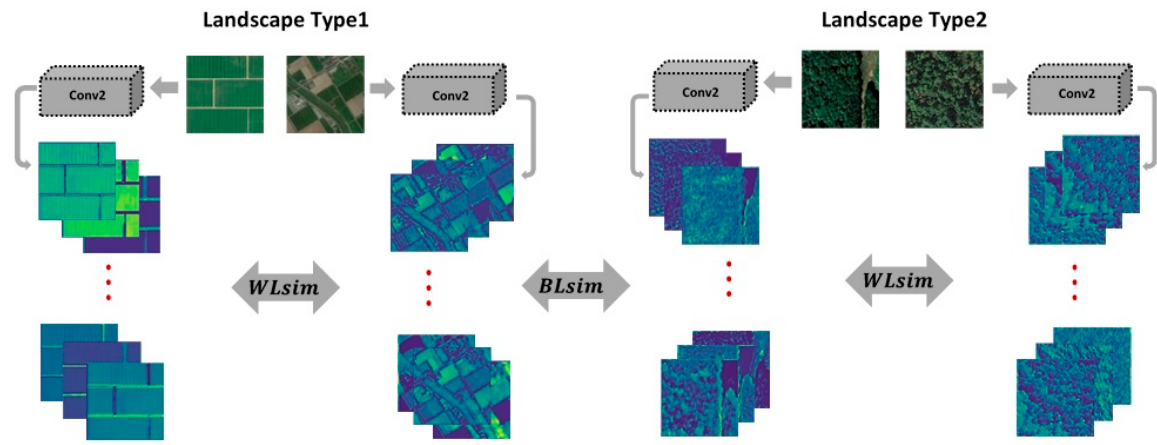
Figure 5. A framework for CNN-feature-based landscape similarity comparison. Notice that within-landscape comparison ( WLsim ) compares features in similar landscapes type 1 (farm landscapes) and landscape type 2 (forest landscapes), while between (an across) landscape comparison ( BLsim ) cross-compares feature maps in landscape type 1 vs. landscape type 2.